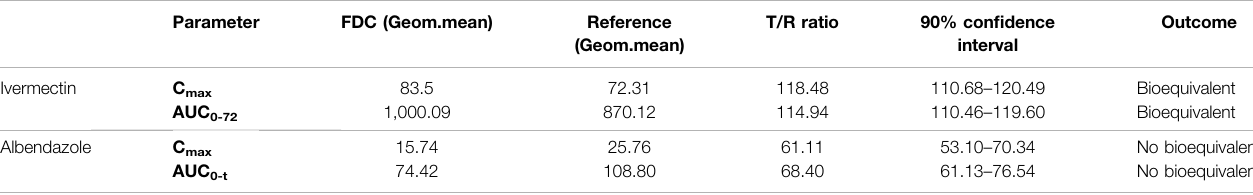
TABLE 3 | Estimation of the bioequivalence for ivermectin (ivermectin/albendazole FDC vs. ivermectin) and albendazole (ivermectin/albendazole FDC vs. albendazole).